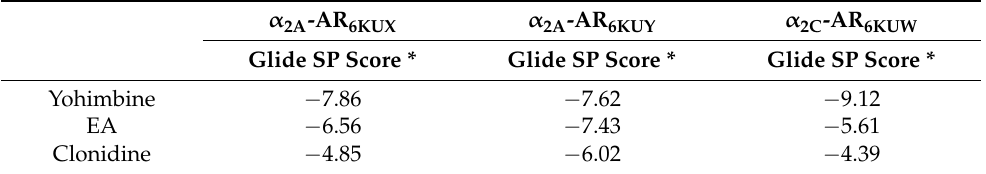
Table 1. Glide score, calculated in kcal/mol, of the best yohimbine, EA and clonidine docked pose